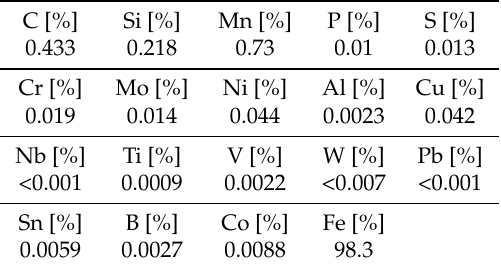
Figure 1. Geometric configuration of the SAE 1045 steel tensile/torsion cylindrical specimen (dimensions in mm). Table 1. Average chemical composition of SAE 1045 steel (% in